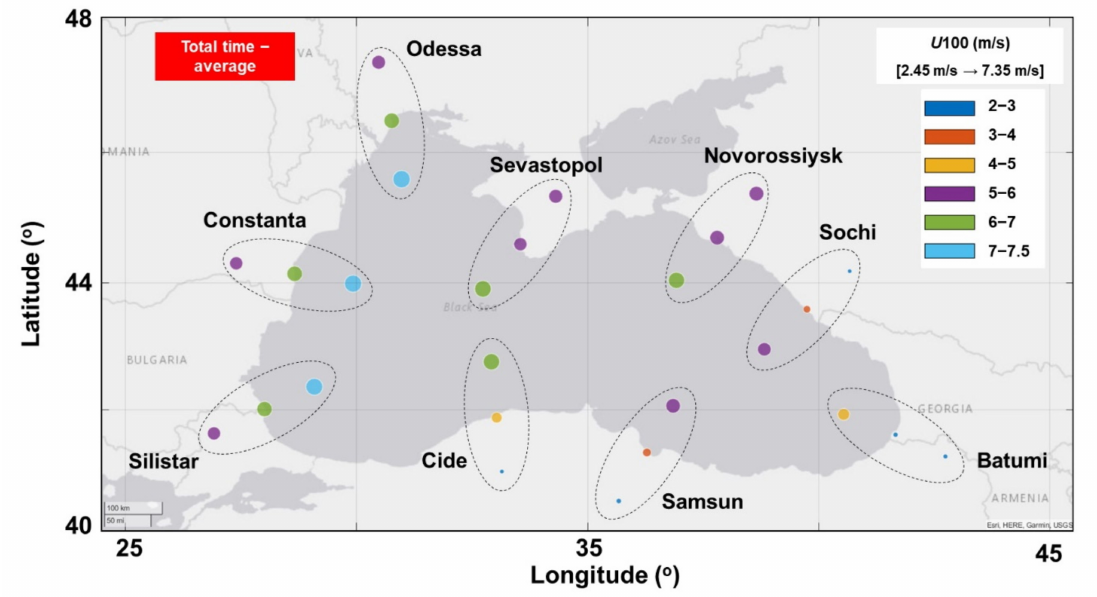
Figure 4. U 100 average values of the ERA5 wind data corresponding to the 20-year time interval from January 2002 to December 2021. The numbers from the square brackets indicate the minimum and maximum values related to this